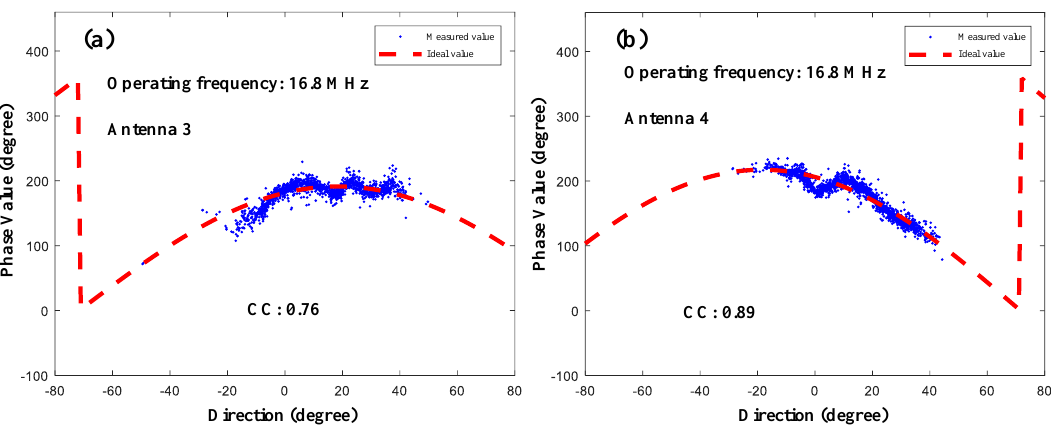
Figure 1. An example of ideal and measured phase values of A m obtained by the MHF radar at 16.8 MHz for different antenna elements. The phase values are measured from ship echoes. ( a ) Antenna 3; ( b ) Antenna